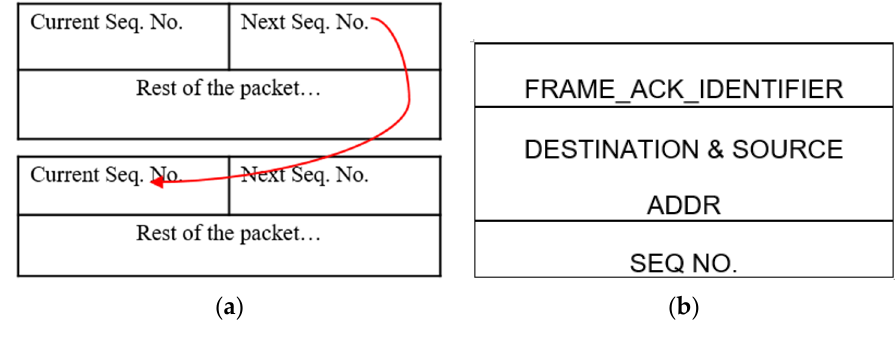
Figure 9. Packets: ( a ) data Packet; and ( b ) ACK packet.